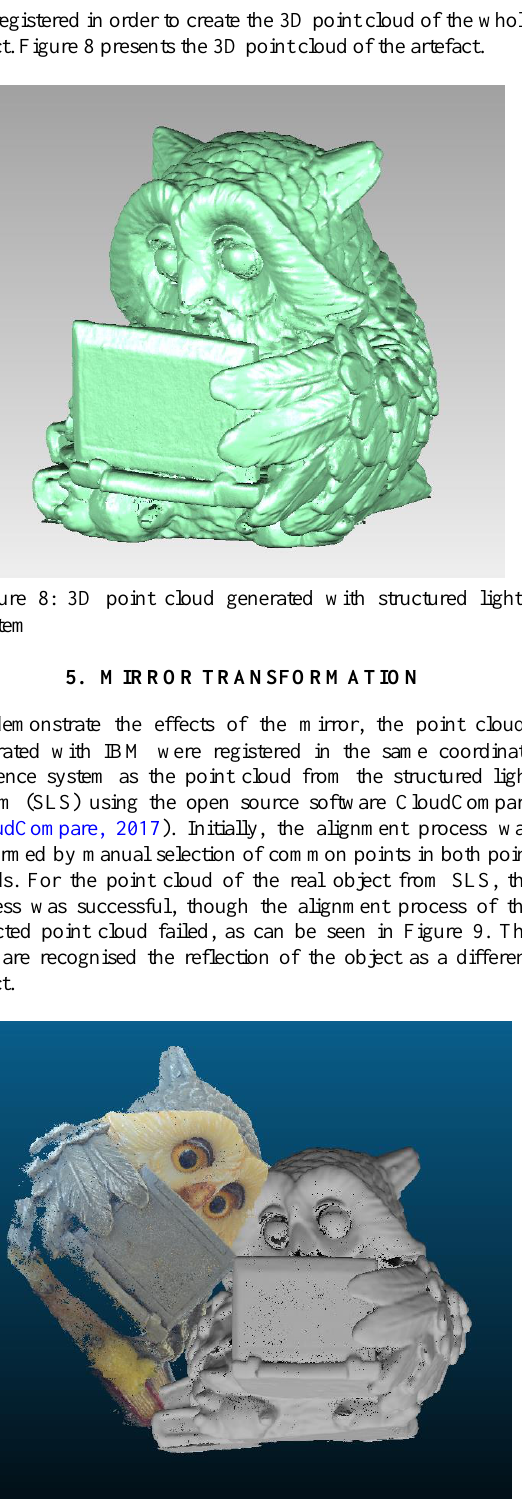
Figure 9: Alignment process between reflection and SLS point clouds